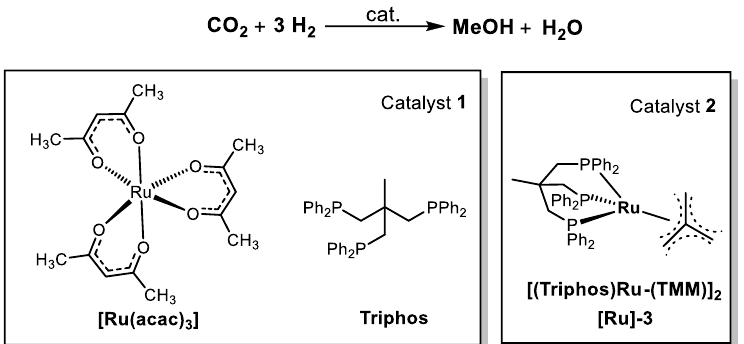
Figure 3. CO 2 hydrogenation to methanol by a single ruthenium phosphine complex.